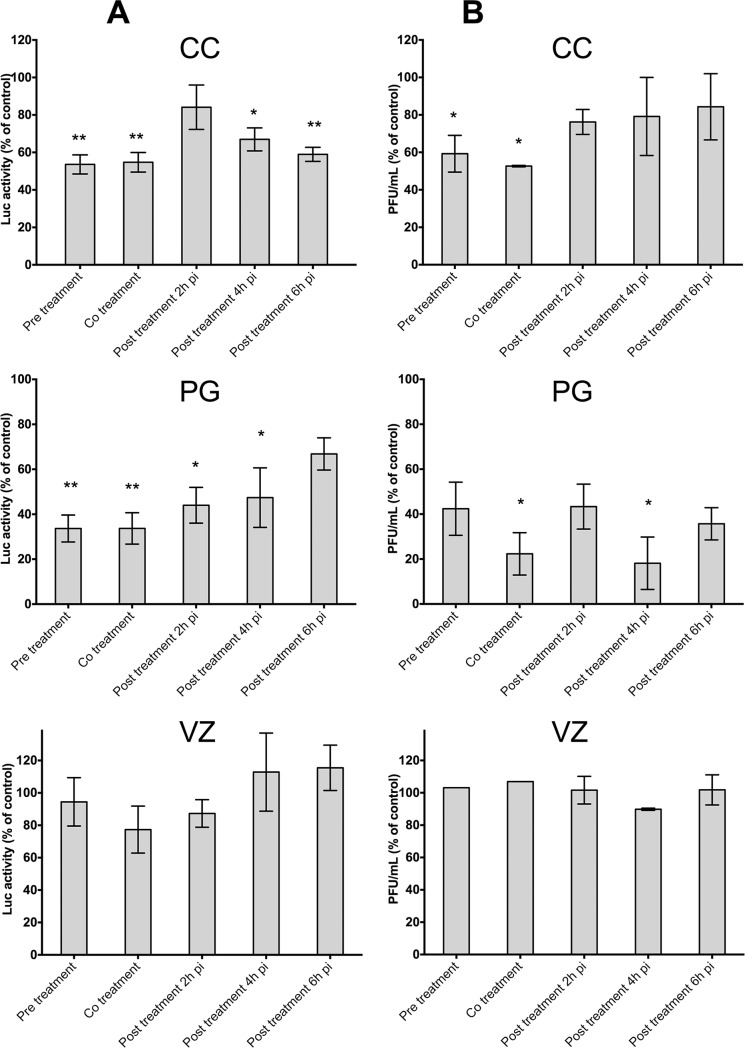
Inhibition of RRV-renLuc replication by the 3 essential oils under the experimental conditions shown in Fig 5.HEK293T was exposed to RRV-renLuc at MOI 2 and treated as shown in Fig 5 with essential oils (A) luciferase activity on HEK293T cells (B) Viral growth by plaque assay on Vero cells. Controls are RRV-renLuc-infected cells infected without treatment by the essential oils. Values are expressed as relative percentage ± SEM (n = 5). (*p < 0.05, **p < 0.01, ***p < 0.005).